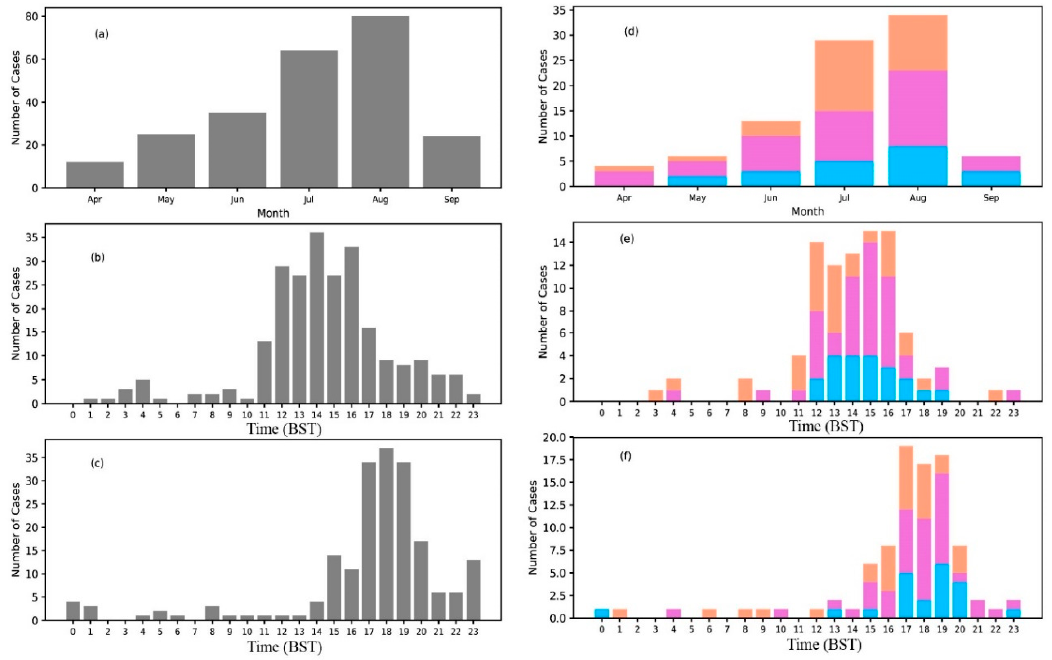
Figure 4. ( a , d ) Monthly variations, ( b , e ) initial time and ( c , f ) dissipating time of LCDM ( grey column), LCDM in AR areas ( blue column), LCDM in BR areas ( purple column) and LCDM in CR areas ( orange column) in Figure 3a in Dabie Mountains during the warm seasons (from April to September) of